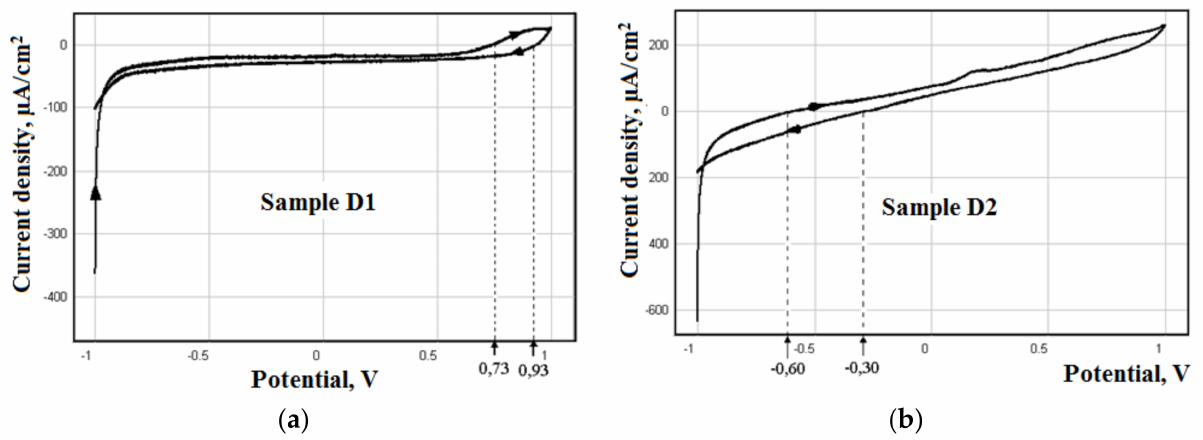
Figure 7. Cyclic polarization curves for samples ( a ) D1 and ( b )